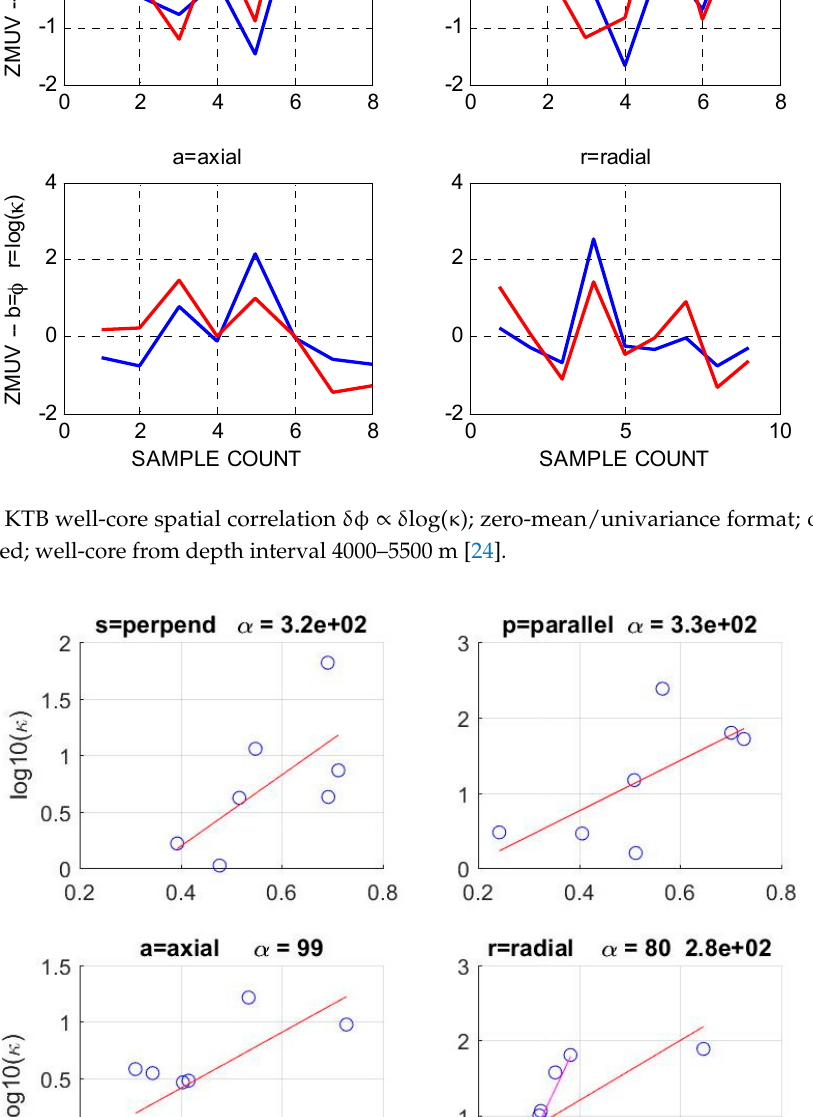
∝ Figure 25. KTB well-core relation κ exp( αφ ); data blue circles; exponent fit for poro-connectivity Figure 25. KTB well-core relation κ ∝ exp( αφ ); data blue circles; exponent fit for poro-connectivity parameter α (red); well-core from depth interval 4000–5500 m [24]. parameter α (red); well-core from depth interval 4000–5500 m